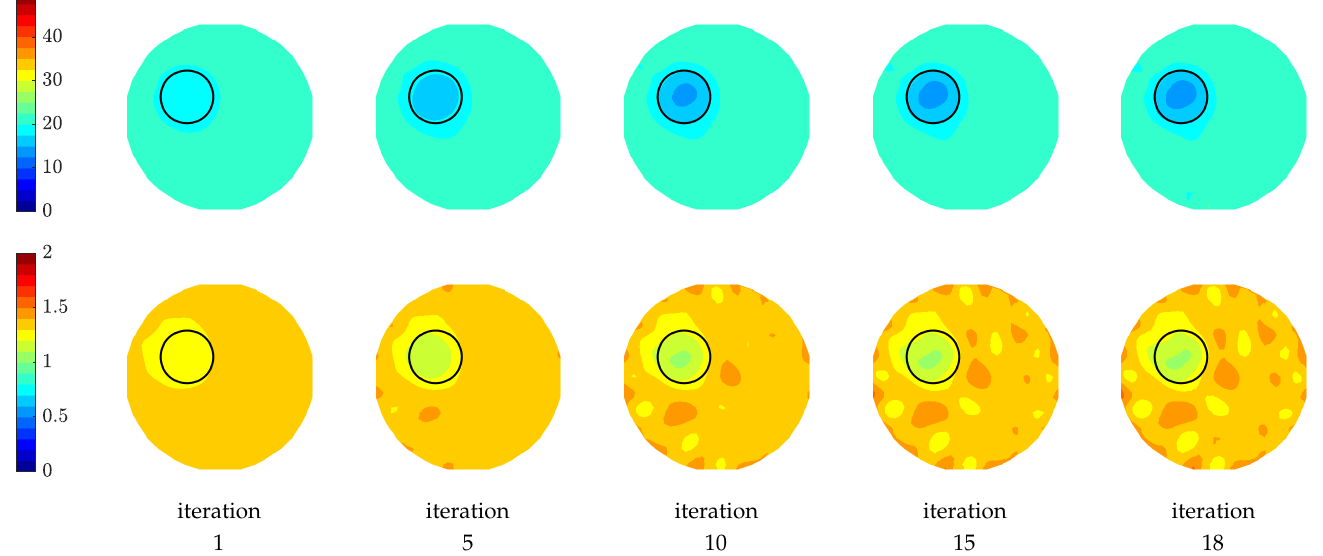
Figure 11. Images of reconstructed relative permittivity ( top row ) and conductivity (S/m) ( bottom row ) at 1500 MHz as a function of iteration number.